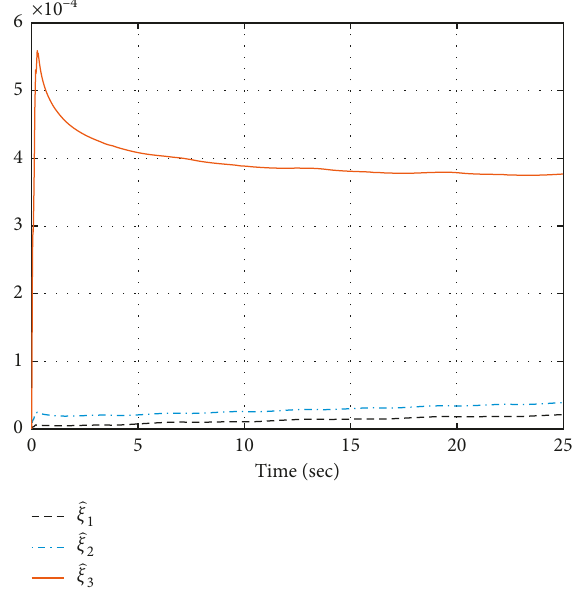
Figure 11: Evolution of the estimation of the